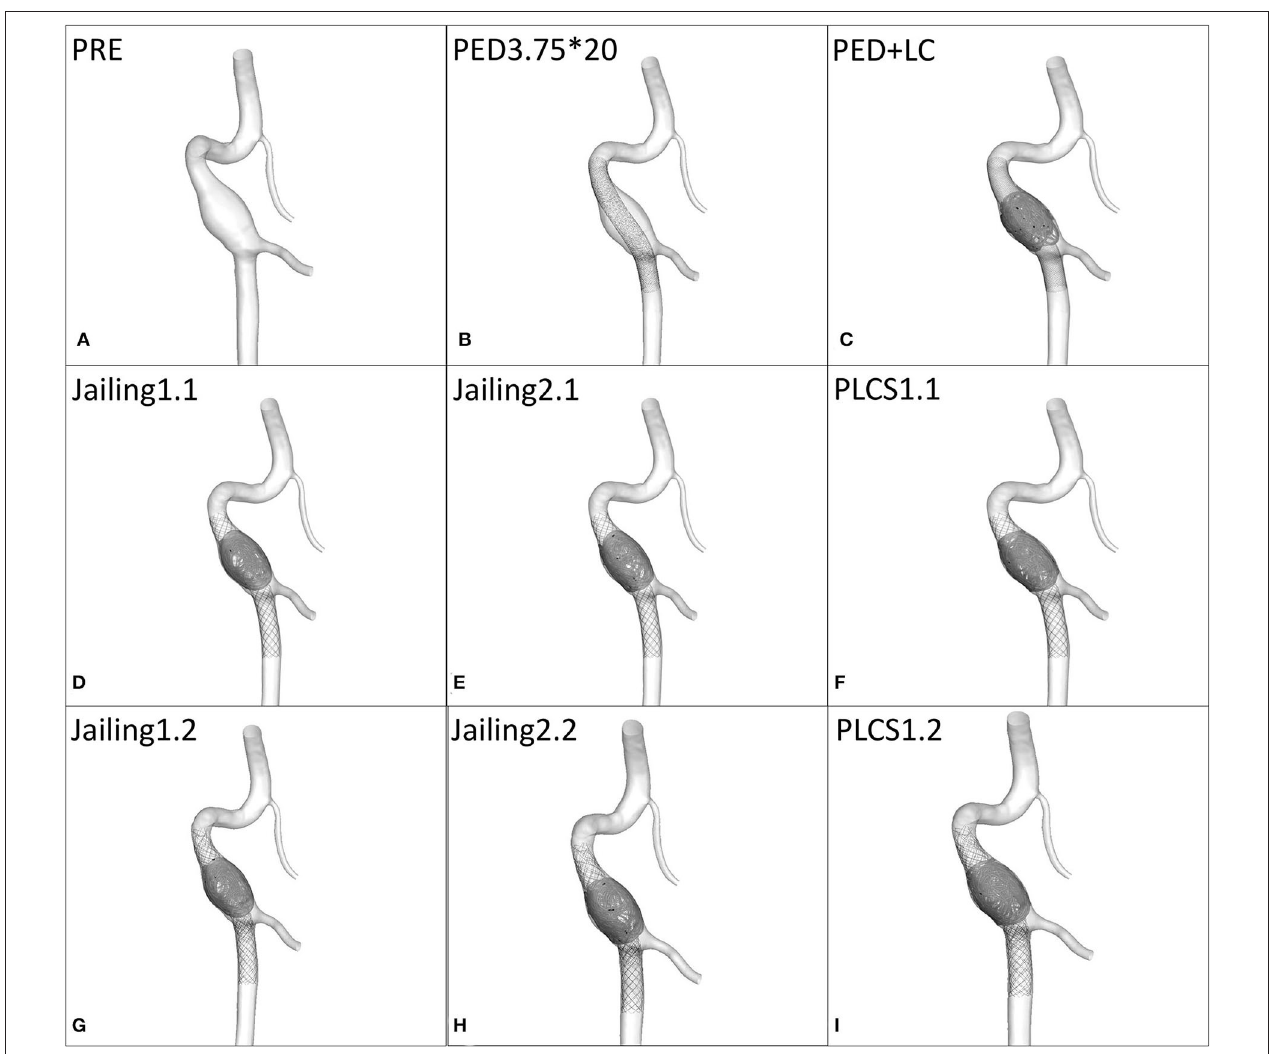
FIGURE 3 | Simulation reconstruction model of aneurysm preoperatively and for eight different treatment approaches. (A) Preoperative aneurysm model. (B) Pipeline device (PED) 3.75*20mm implantation model. (C) Large coil; Microplex-10 8 x 30cm x 2 + 7 x 30cm and PED-3.75 x 20mm. (D–F) Single LVIS stent 4.5 x 20mm (Jailing 1.1, Jailing 2.1, and PLCS 1.1). (G–I) Dual LVIS stent 4.5 x 20mm, 4.5 x 15mm (Jailing 1.2, Jailing 2.2, and PLCS